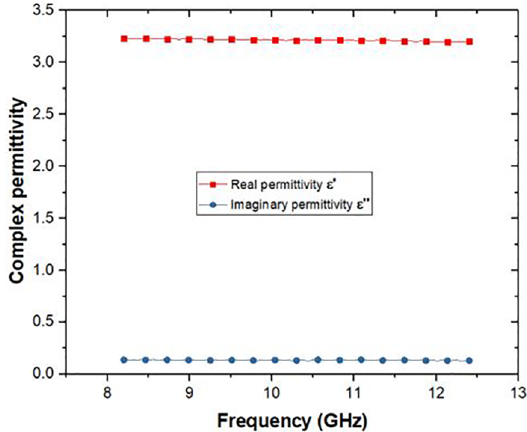
Figure 5. Complex permittivity of pure epoxy resin.